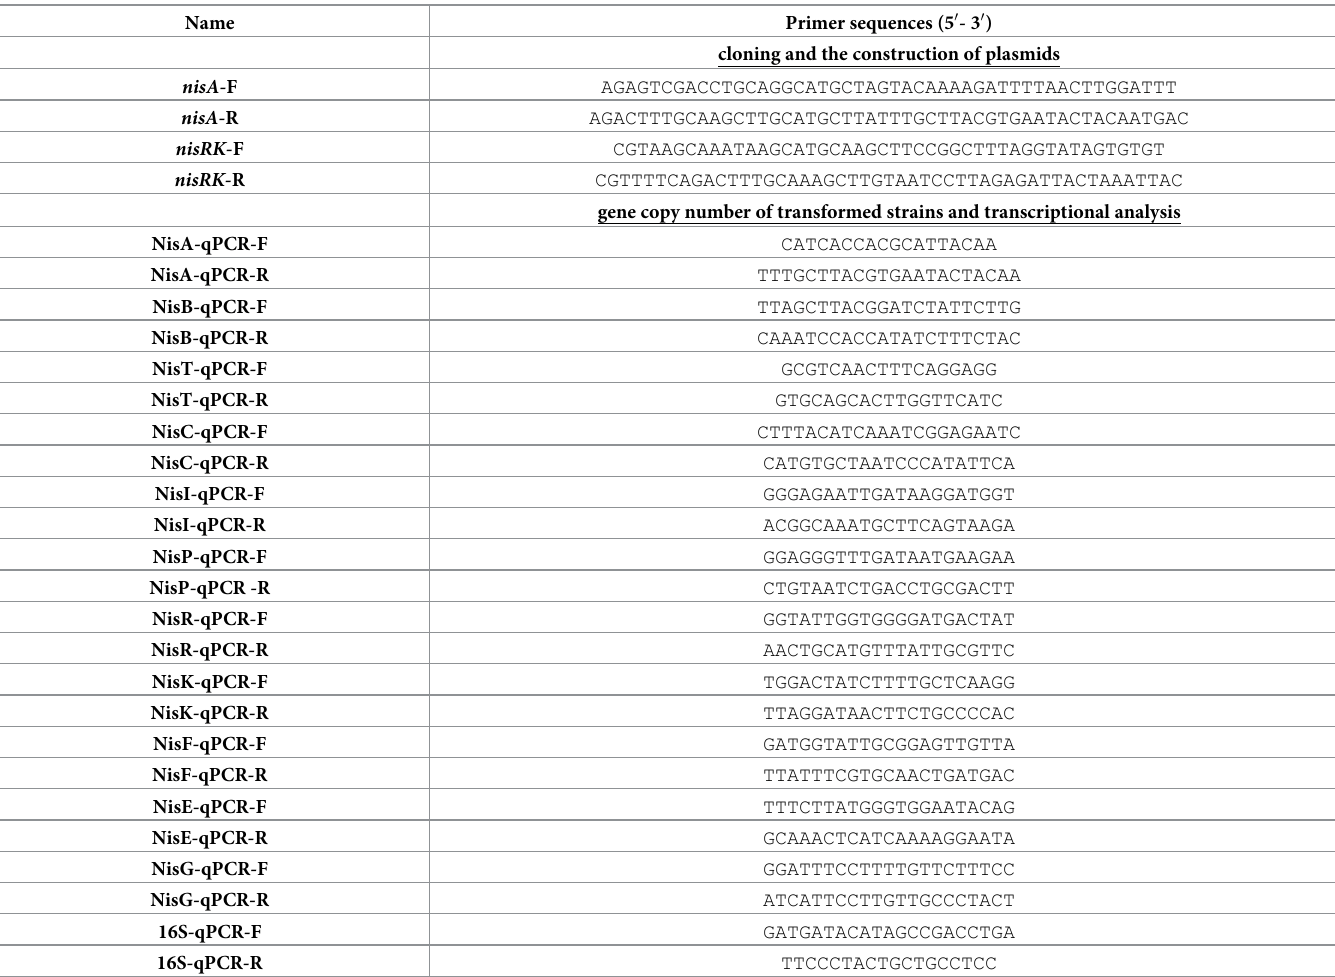
Table 1. Primers used in the